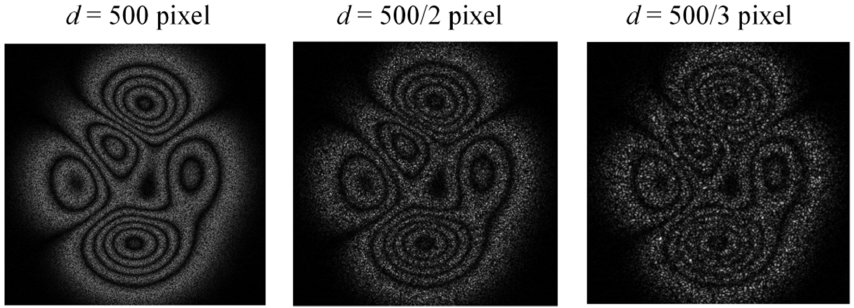
Figure 2. Simulated fringe pattern with the different aperture sizes.